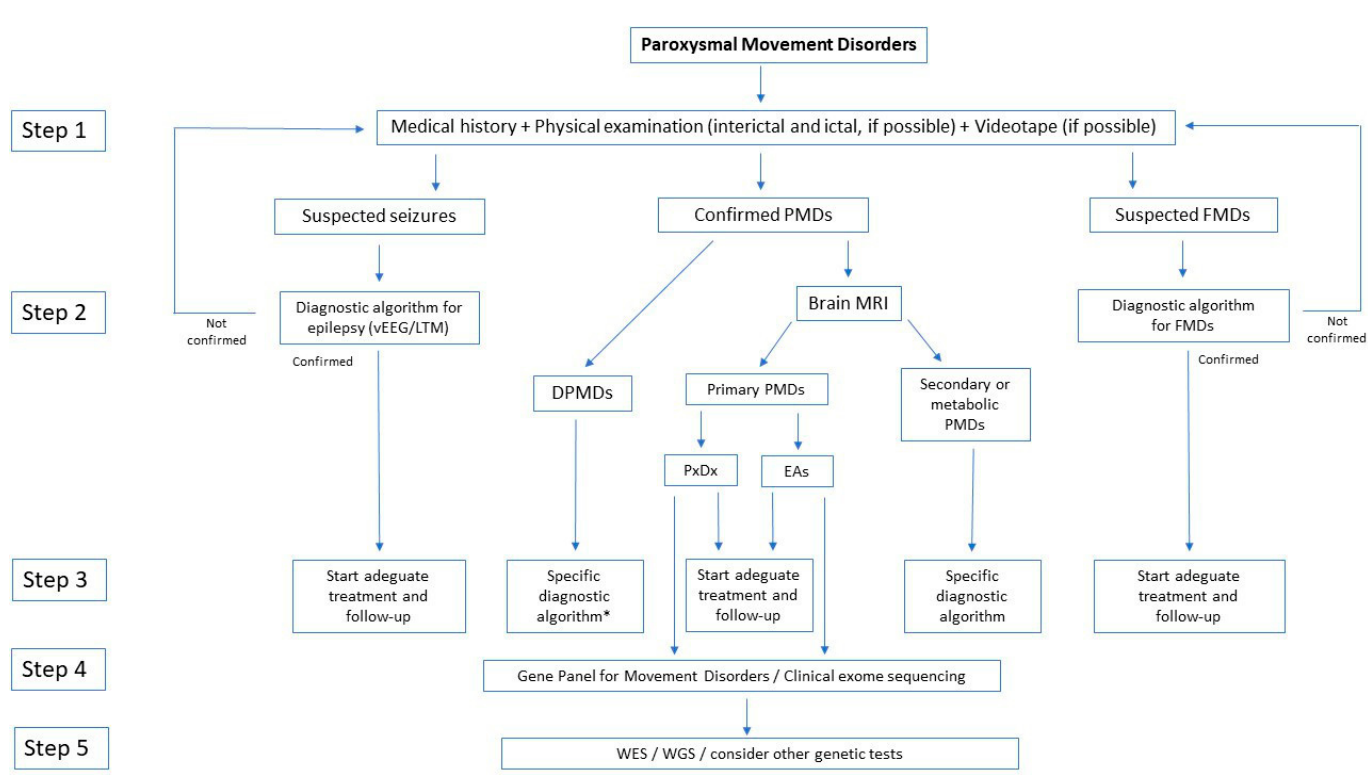
Figure 5. Operative flowchart for pediatric-onset PMDs. DPMDs: developmental PMDs; EAs episodic ataxias; FMDs: functional movement disorders; LTM: long term EEG monitoring; PxDx paroxysmal dyskinesias; vEEG: video electroencephalogram; WES: whole exome sequencing; WGS: whole genome sequencing. * Please refer to Box 1 for specific diagnostic algorithm for DPMs.